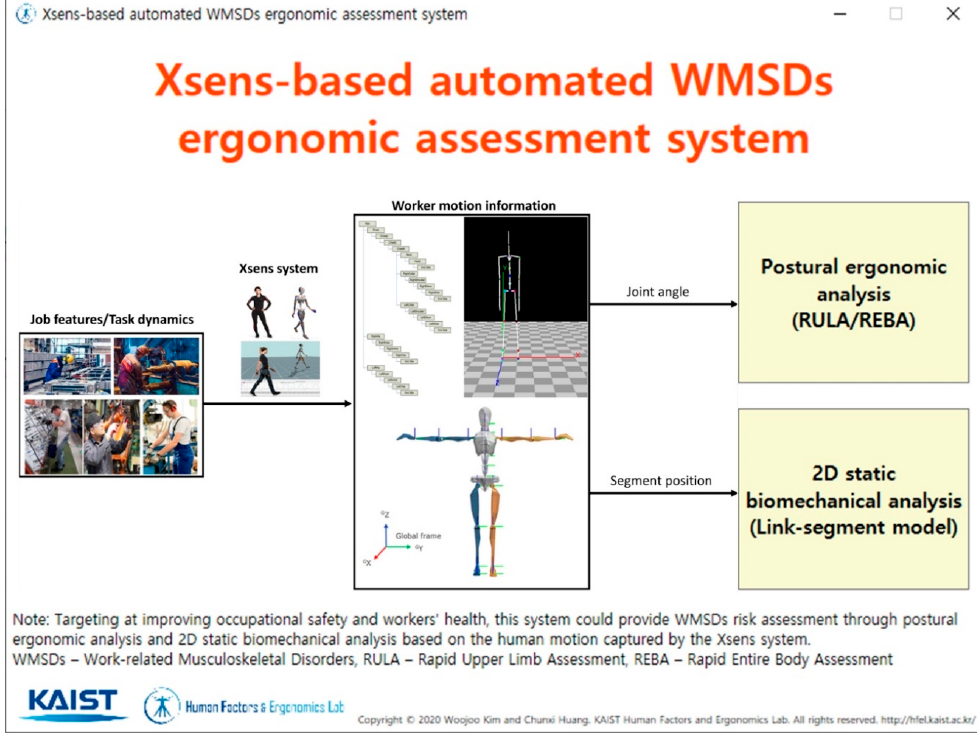
Figure 3. The main interface of the developed system.